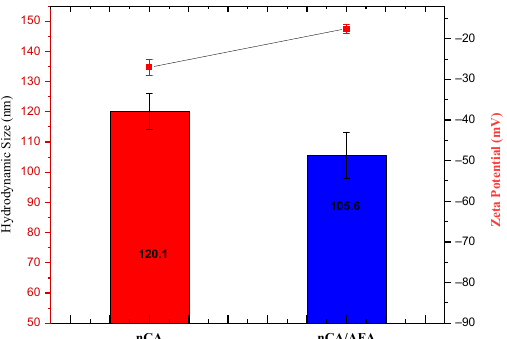
Figure 7. Average hydrodynamic diameter measurement (blue) and zeta potential (red).